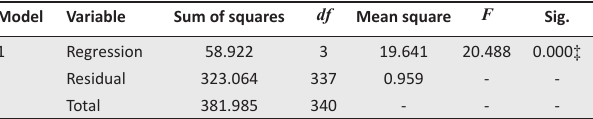
TABLE 2-A1: ANOVA † . Model Variable Sum of squares